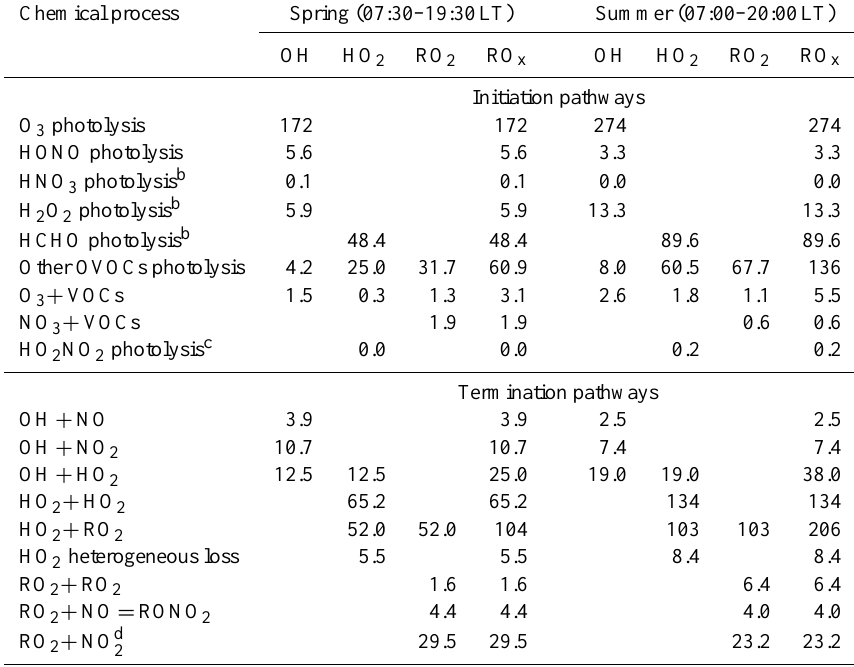
Figure 8 Fig. 8. Sensitivity of RO x production rates to surface O 3 levels at WLG in (a) spring and (b) summer. Table 4. Major initiation and termination processes of RO x radicals and their contribution as daytime averages at WLG a . Chemical process Spring